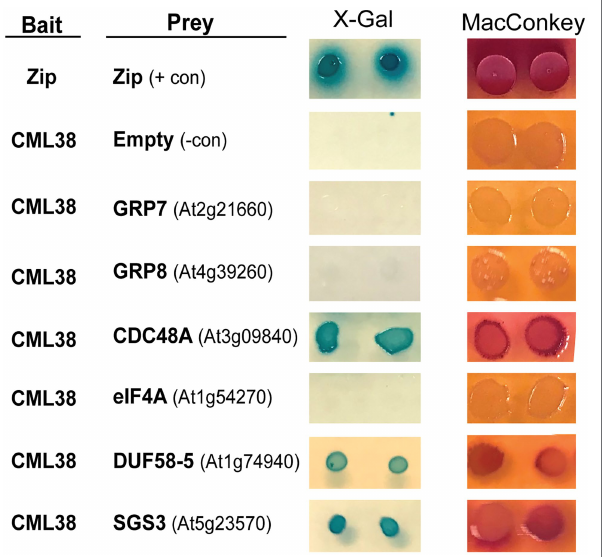
FIGURE 1 | Analysis of CML38-interacting proteins by Bacterial Two Hybrid Assay. Bacterial Two Hybrid (BACTH) of CML38 with selected proteins of interest. Escherichia coli BTH101 cells were co-transformed with bait ( CML38 /pKNT25) and prey (protein of interest/pUT18c) constructs (see Materials and Methods). Gene names are listed and gene accession numbers are shown parenthetically. Empty , indicates a negative control consisting of the pUT18c construct without a protein fusion. Zip , indicates a positive control consisting of bait and prey constructs with two fragments of a leucine zipper motif of the yeast protein GCN4. Interaction analysis was performed by plating on M63 minimal media with the β -galactosidase substrate X-Gal , and a fermentation indicator MacConkey media supplemented with maltose, as described in the Materials and